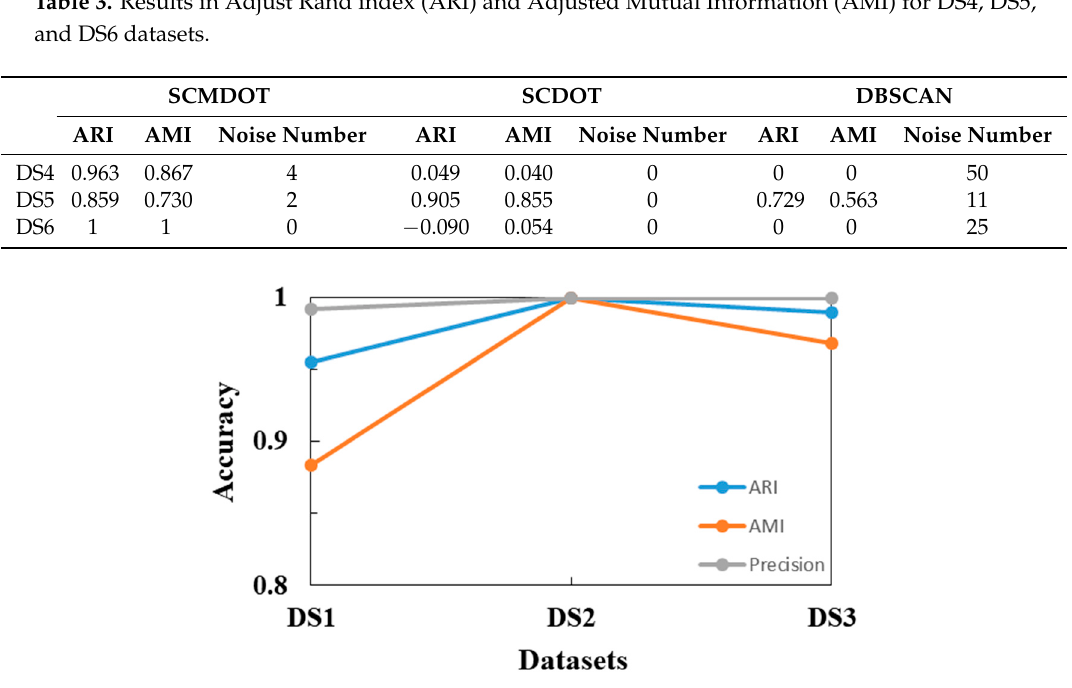
Figure 6. Illustration of clustering results in Experiment 2. ( a – c ) The clustering results of DS4; ( d – f ) The clustering results of DS5; ( g – i ) The clustering results of DS6.